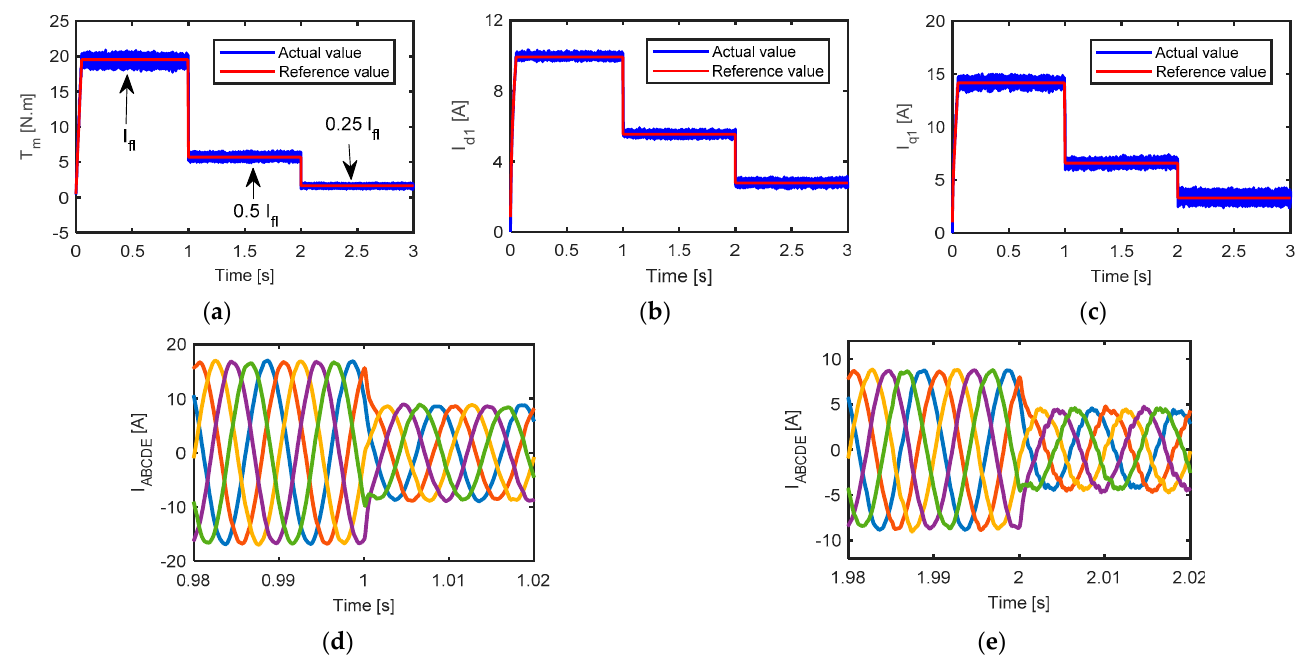
Figure 9. Simulated performance of the five-phase combined star-pentagon SynRM at rated speed and different loads, ( a ) average torque, ( b ) d-axis current, ( c ) q-axis current, and ( d , e ) zoom-in view of five-phase currents.